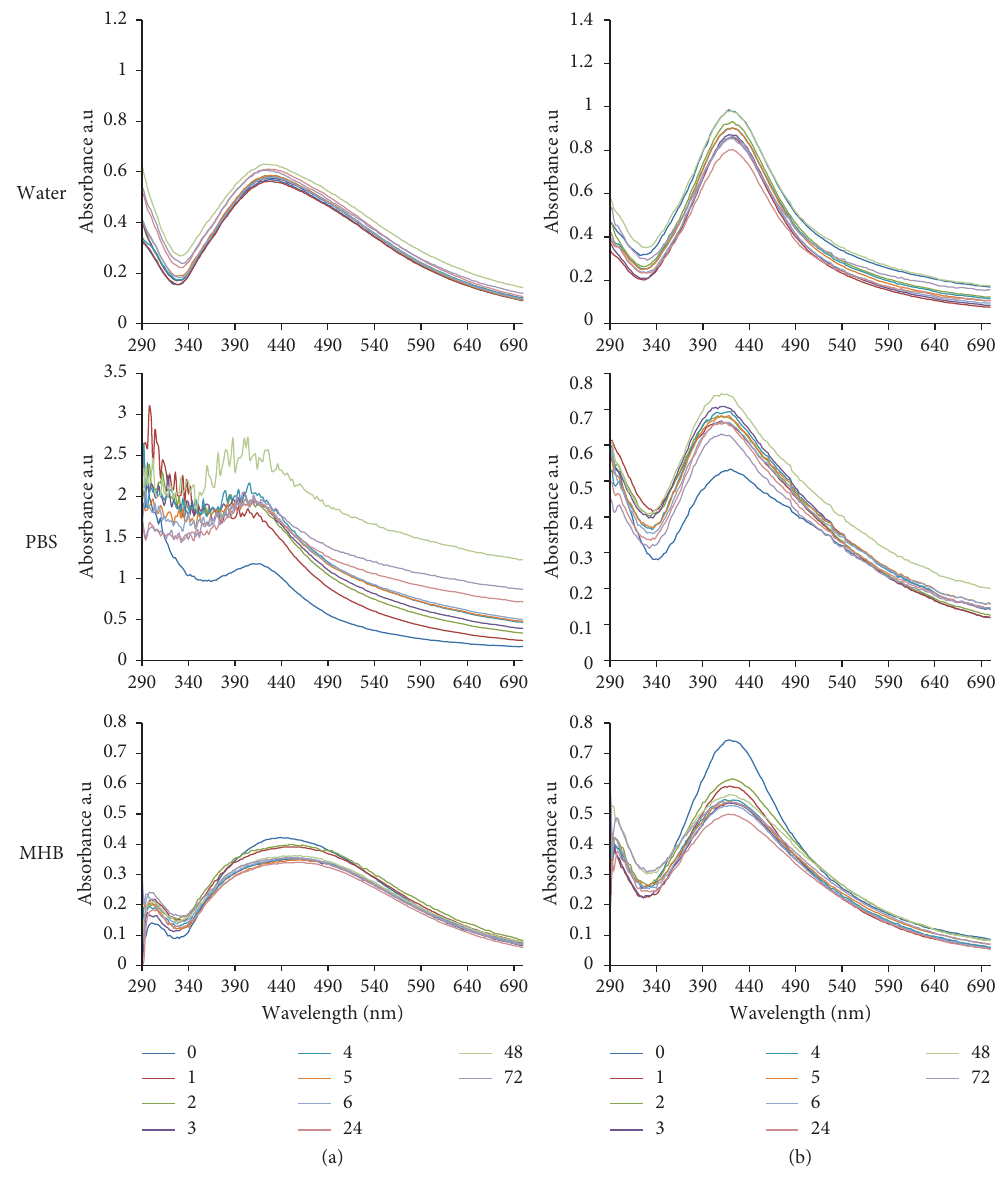
Figure 5: UV-vis spectra of (a) GA-AgNPs_0.1g; and (b) GA-AgNPs_0.4g in water, PBS, and MHB measured over a 72 hour period. Table 2: ZOIs as a measure of antimicrobial activity of GA-AgNPs. Microbes